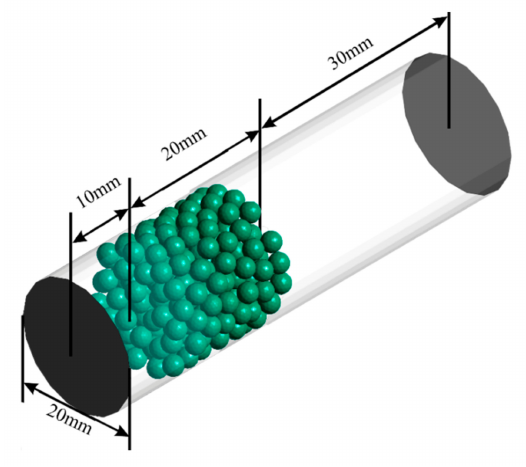
Figure 2. Filter model: solid spherical granules ( d g = 3 mm, ε = 0.439).